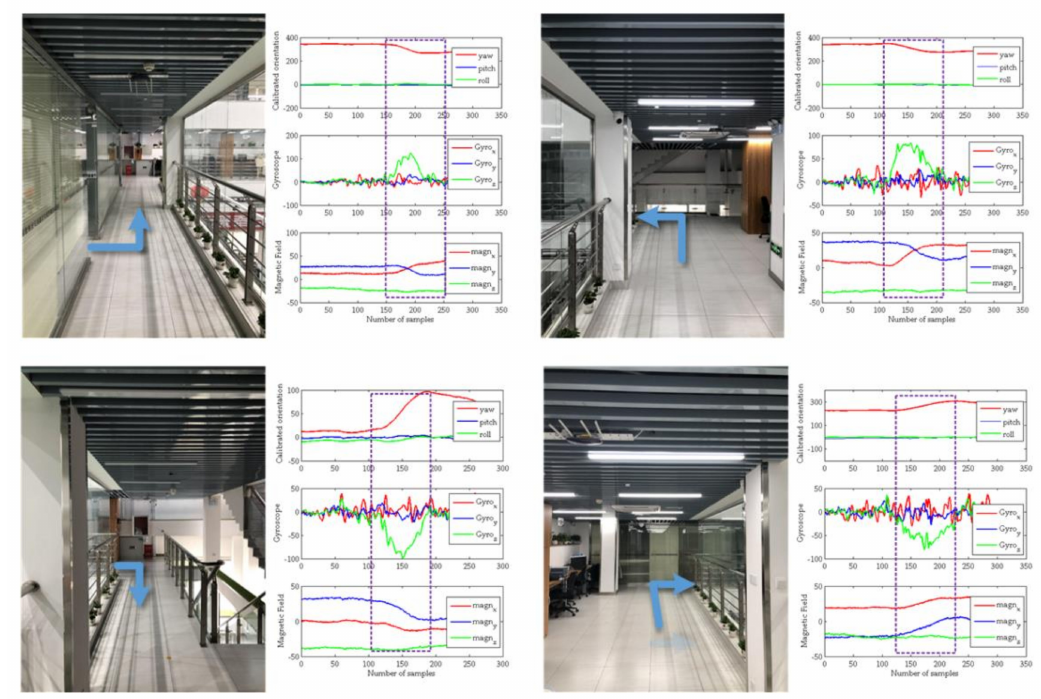
Figure 6. Characteristic data of di ff erent turning